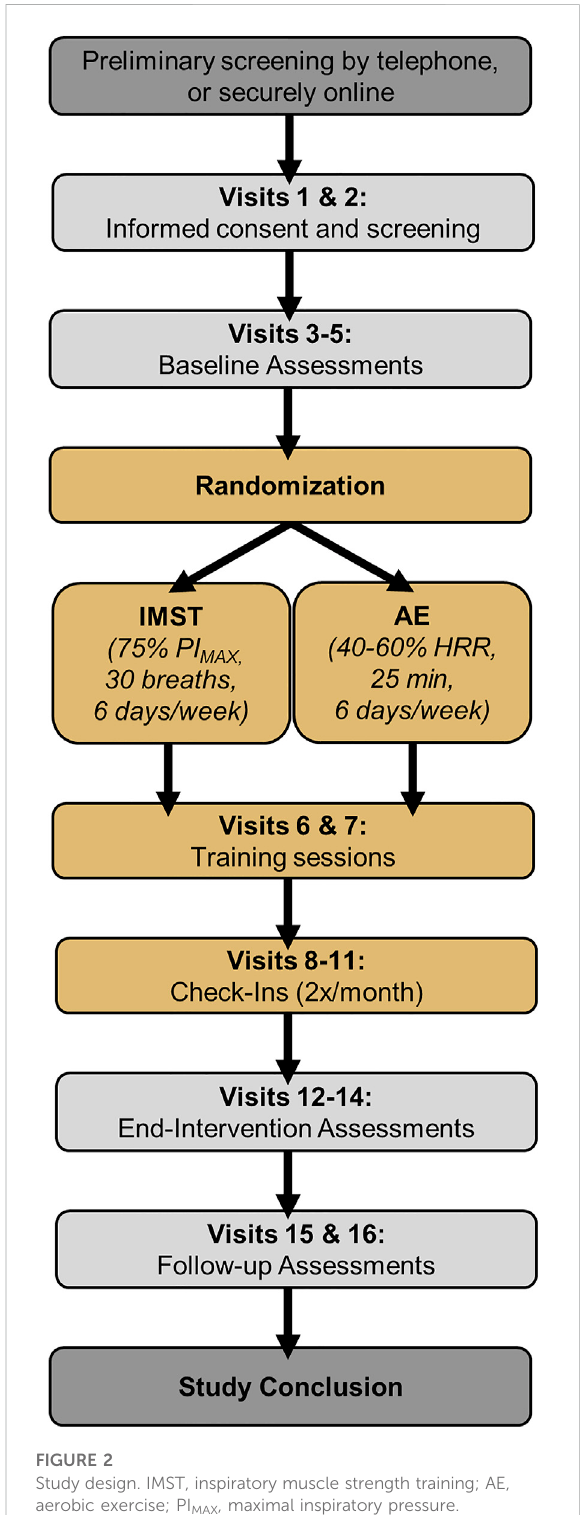
FIGURE 2 Study design. IMST, inspiratory muscle strength training; AE, aerobic exercise; PI MAX , maximal inspiratory